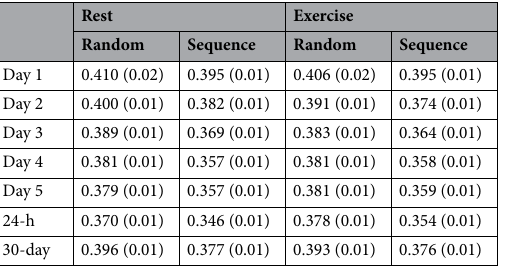
Table 4. Mean reaction time (SD) for rest and exercise groups across